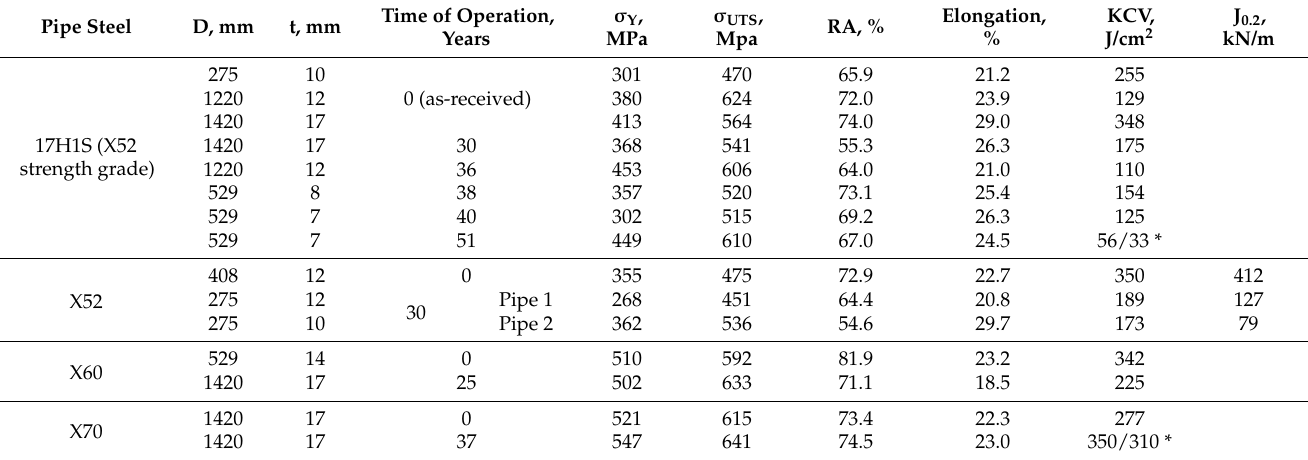
Note. * KCV values obtained for transverse specimens relative to the pipe